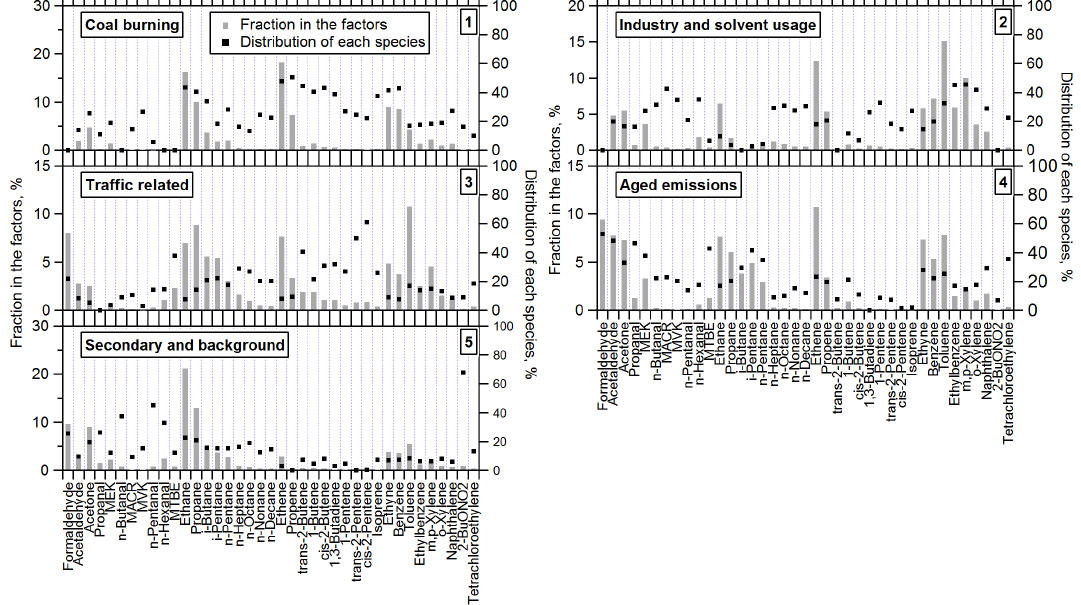
Fig. 4. Profiles of the five factors resolved by the PMF model and the distributions of species among these factors in